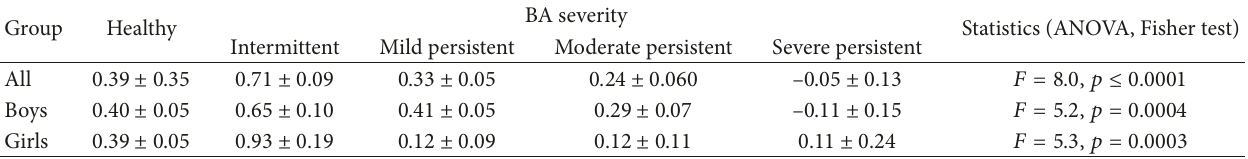
Table 4: Standard deviation score (SDS) at children with various severity of BA in comparison with healthy children. BA severity Group Healthy Statistics (ANOVA, Fisher test) Intermittent Mild persistent Moderate persistent Severe persistent